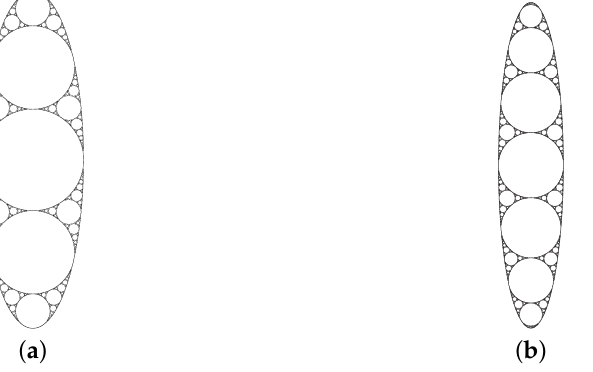
√ 11 ( a ) and for a / b = 5 ( b ). In both cases, r min = a